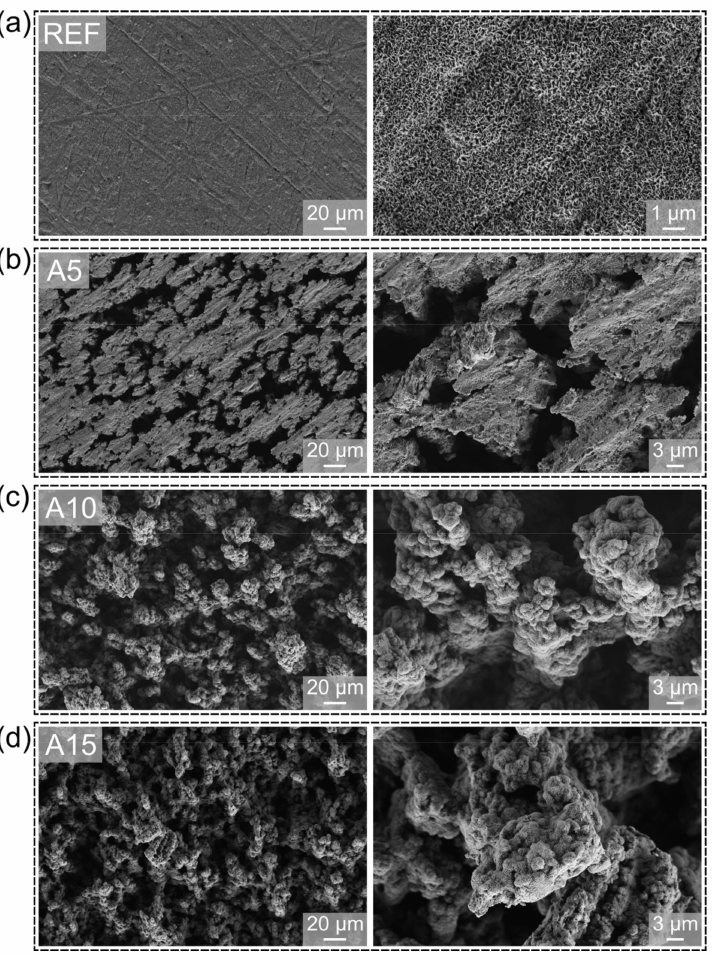
Figure 2. SEM images of the untreated reference surface ( a ) and surfaces etched for 5 min ( b ), 10 min ( c ) or 15 min ( d ). Images were taken after boiling took place on the